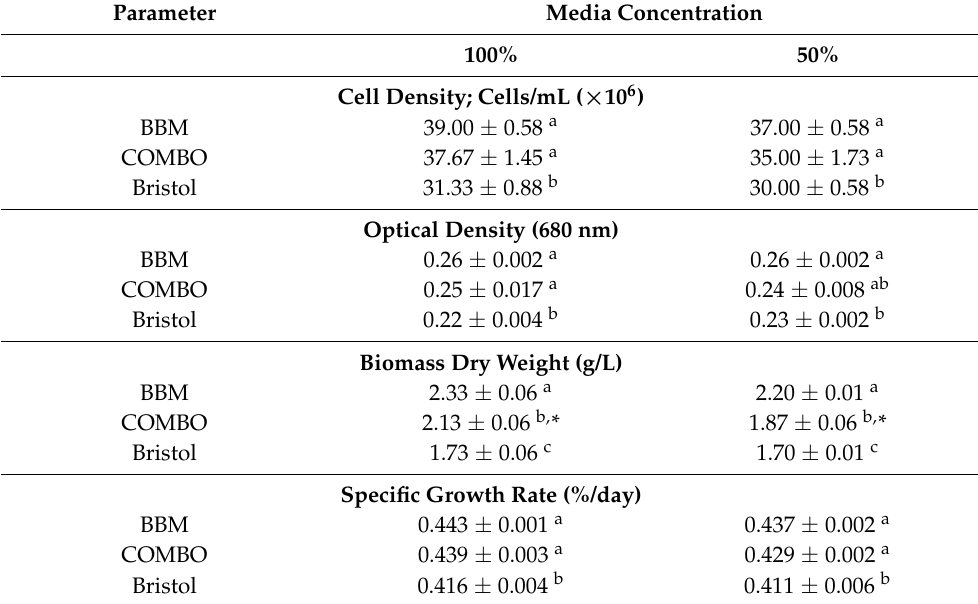
Table 2. Mean growth parameters of Ankistrodesmus falcatus cultured in different media. Numbers are means ± standard errors. a–c Value under the same parameter represents the mean samples with a significant difference between culture media ( p ≤ 0.05). * Value under the same parameter represents the mean samples with a significant difference between concentrations ( p ≤